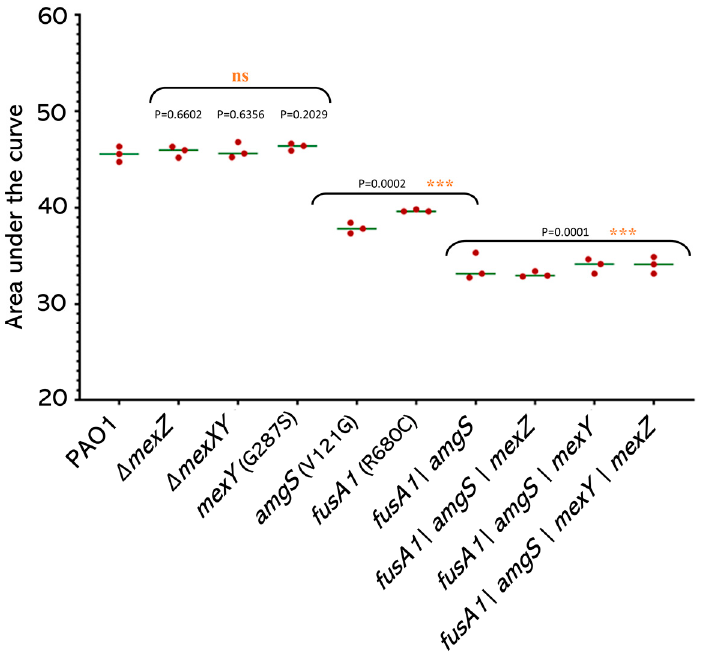
Figure 3 . Growth of engineered mutants. Growth of three biological replicates of the PAO1 strain and isogenic mutants in L-broth, summarized as area under the curve. “ns”, no significant differ- ence; ***, significantly different from the PAO1